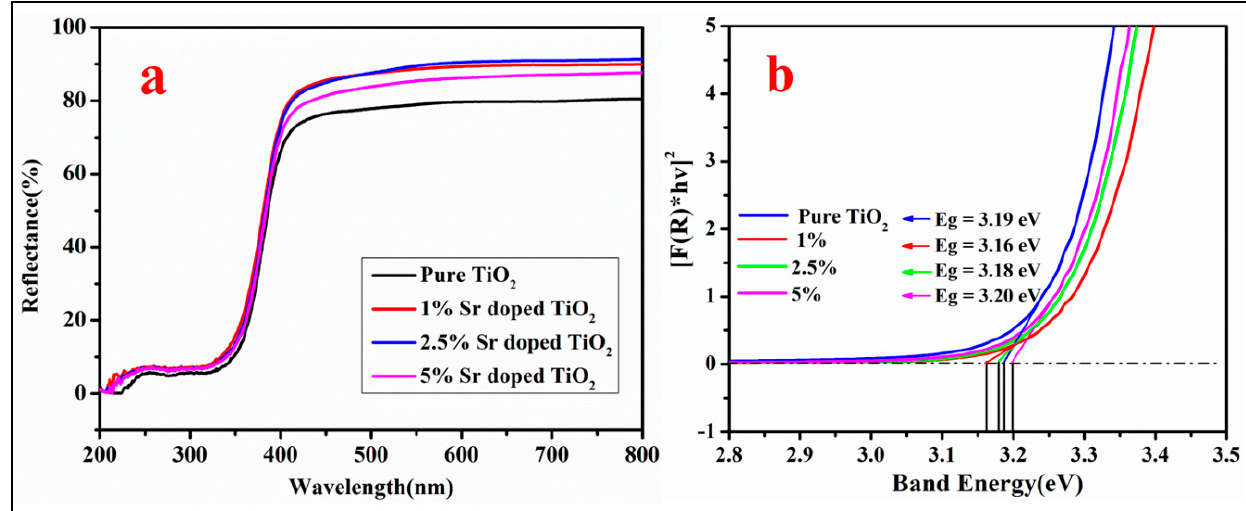
Figure 6. ( a ) UV − vis DRS and ( b ) Kubelka − Munk plots of pristine TiO 2 and 1, 2.5 and 5% Sr-doped TiO 2 NPs.